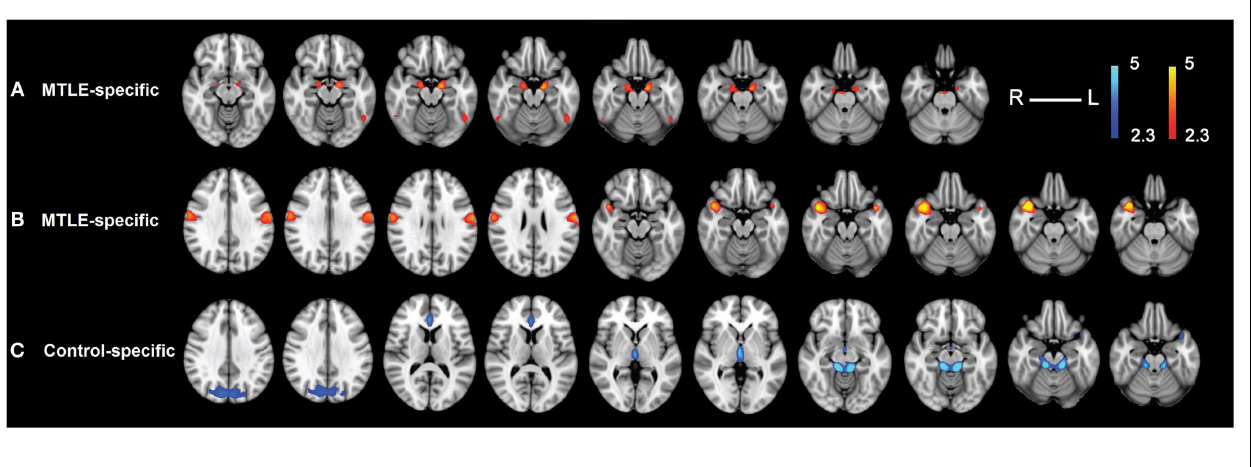
reliable cluster. Z -values range between 2.3 and 5 in both cases.To be compatible with the results in Figure 3 , we chose to illustrate the MTLE-specific networks (A,B) in red and the control-specific network (C) in